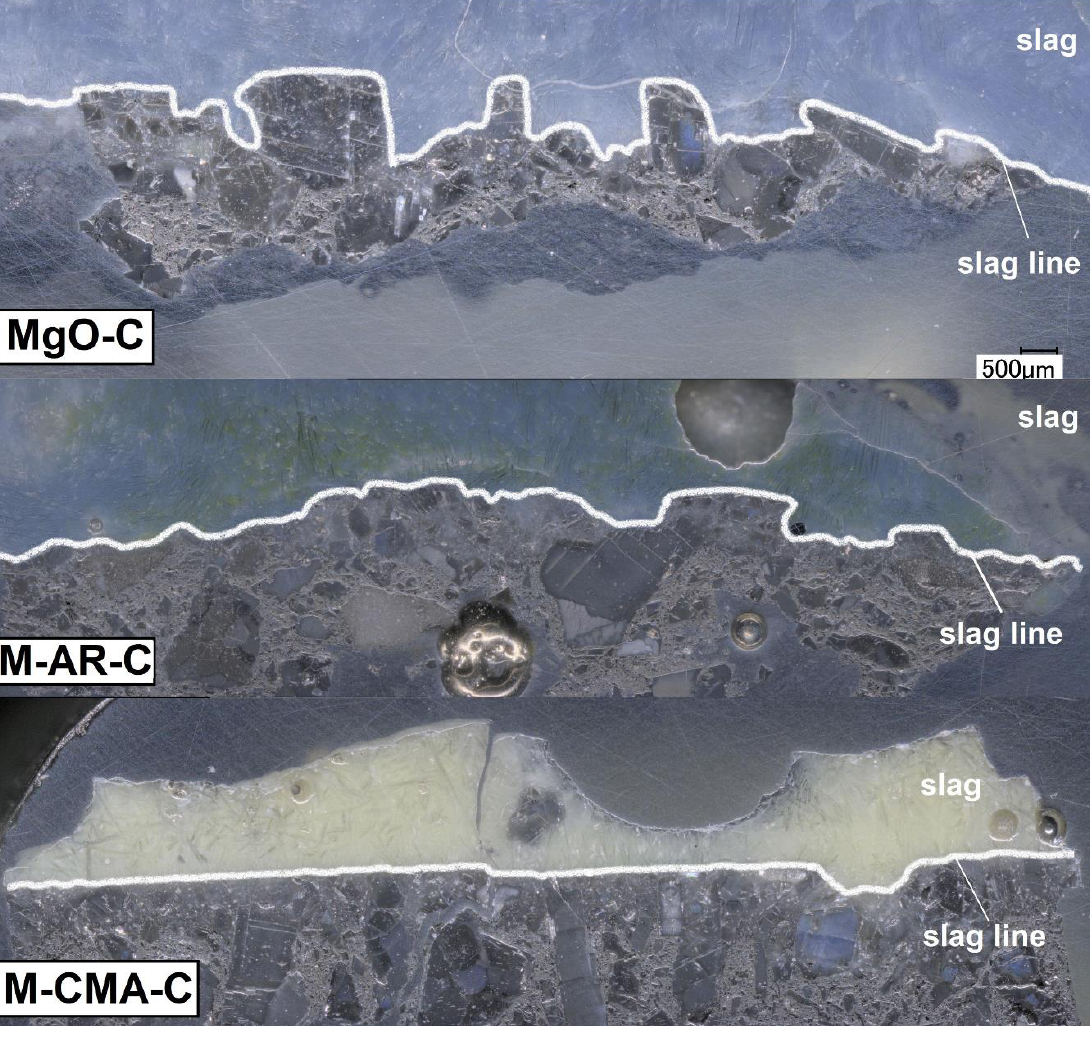
Figure 4. Polished slag-refractory interface after corrosion test.